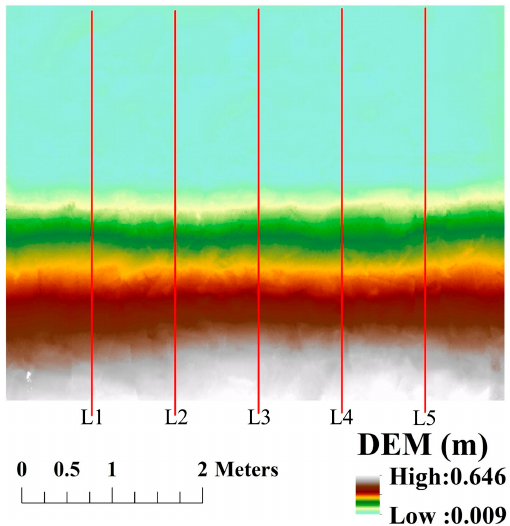
Figure 2. The initial beach has a slope of approximately 15°. Five beach profiles are distributed evenly with a cross-profile distance of 0.93